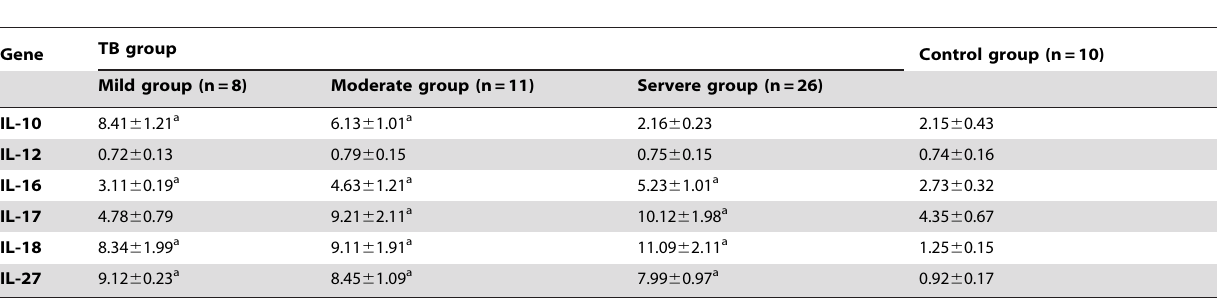
Table 5. The mRNA expression of the ILs in the different pathogenetic condition TB groups.